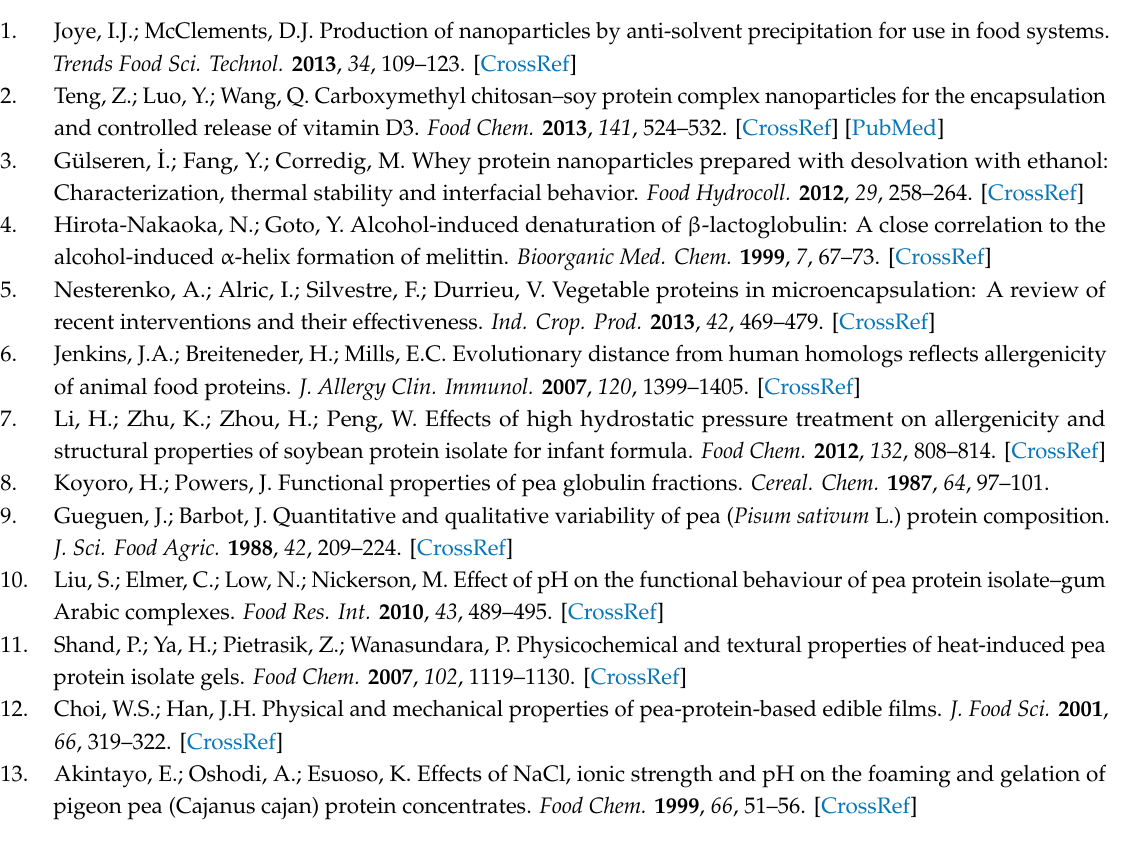
Figure S1: Particle size distribution of desolvated pea protein particles at pH 3 and pH 10 before and after homogenization at 5000 psi for 5 min, Figure S2: A representative FTIR spectra of 3X desolvated PPN and at pH 3 synthesized at 25 ◦ C, Figure S3: Secondary structure components of raw pea protein isolates (PPI), supernatant soluble pea protein at pH 10 and pH 3 without desolvation, Figure S4: SEM images of re-dispersed pea protein particles at pH